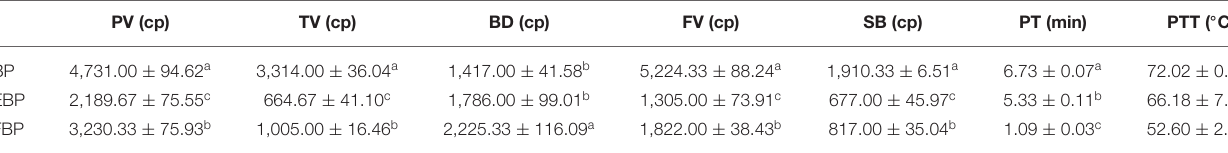
TABLE 6 | Pasting properties of BP, EBP, and FBP.